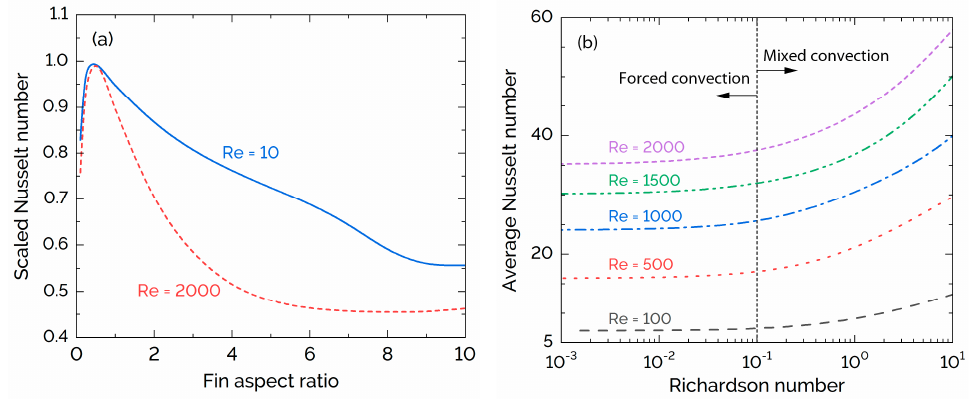
Figure 6. Effects of inertial and buoyancy forces. ( a ) Scaled Nusselt number as a function of fin aspect ratio for Re = 10 and 1000, and ( b ) average Nusselt number as a function of the Richardson number for several Reynolds numbers.